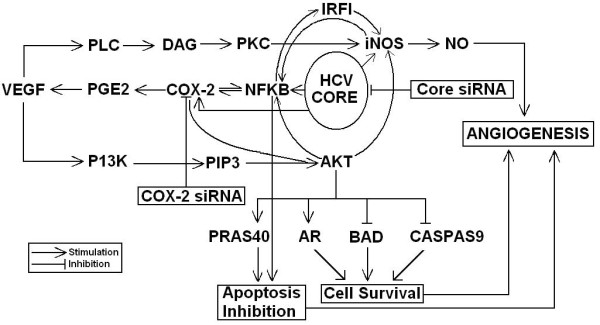
HCV Core protein affects on the cellular genes involved in oxidative stress, apoptosis, cell survival and angiogenesis. Schematic diagram illustrating the role of HCV Core on cellular genes. In HCV, normal angiogenesis process can be malignant by deregulation of genes involved in this pathway. HCV Core protein up-regulates NFKB, which further up-regulates iNOS and COX-2 pathways, and inhibit apoptosis by blocking bad and caspase pathway. COX-2 up-regulation leads to apoptosis inhibition via VEGF pathway. VEGF can trigger angiogenesis either by iNOS or AKT activation. AKT singling also up-regulates AR and inhibit BAD and Caspase9 that leads to angiogenesis via cell survival. AKT also have direct impact on iNOS regulation that also escorts to angiogenesis. We corroborated that using siRNA against Core, or Cox-2 either alone or in combination can block angiogenesis directly or via Cox-2 reduced expression. PLC, PhosphoLipase; DAG, diacylglycerol; PKC, protein kinase C; iNOS, inducible nitric oxide synthase; NO, nitric oxide; VEGF, vascular endothelial growth factor; PGE2, prostaglandin E2; COX-2, cyclooxygenase-2; NFKB, nuclear factor kappa-B; P13K, phosphoinositide-3-kinase; PIP3, phosphatidylinositol 3,4,5-trisphosphate; PRAS40, proline-rich Akt substrate of 40 kDa; AR, Aldose reductase; BAD, Bcl-XL/Bcl-2-associated death promoter; CASPASE9, apoptosis-related cysteine peptidase.